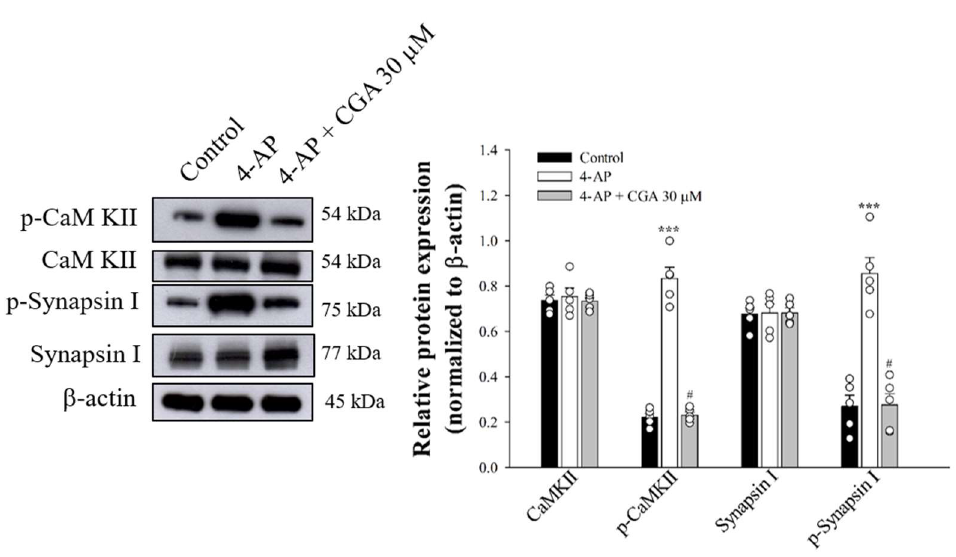
Figure 6. Effect of CGA on CaMKII and synapsin I phosphorylation evoked by 4-AP. CGA was added 10 min before the addition of 4-AP. Data are presented as mean ± SEM. ( n = 5 per group). ***, p < 0.001 vs. control group. #, p < 0.05 vs. 4-AP-treated group.